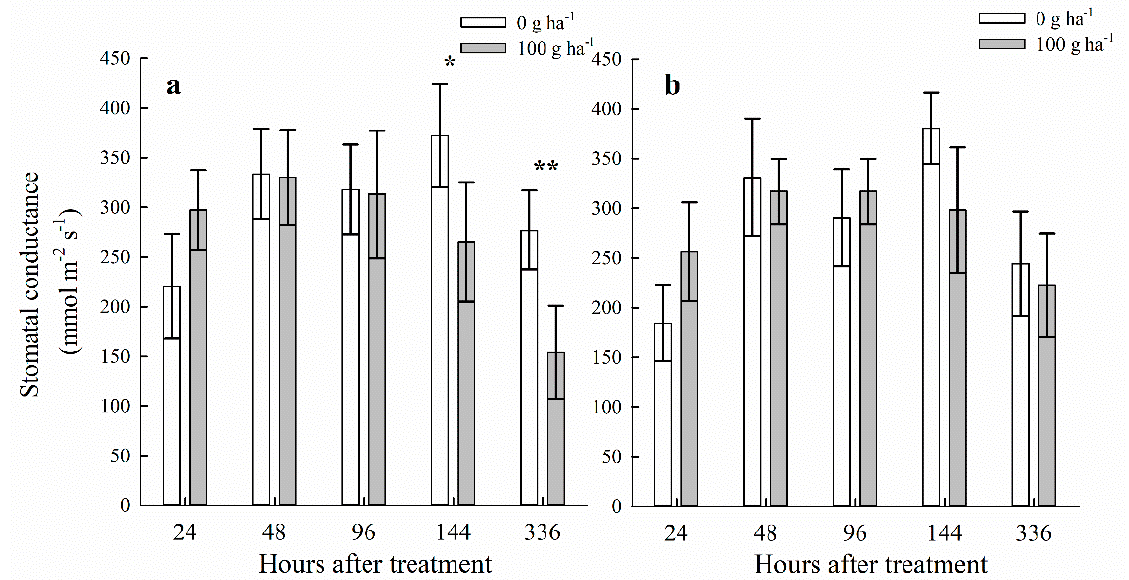
Figure 3. Stomatal conductance (mmol m − 2 s − 1 ) of Eragrostis plana populations CHK ( a , no stress) and DRY ( b , drought) with and without herbicide at 24, 48, 96, 144, and 336 h after application of quizalofop. Error bars represent 95% confidence intervals. * t -test ( α = 0.05); ** t -test ( α = 0.01).